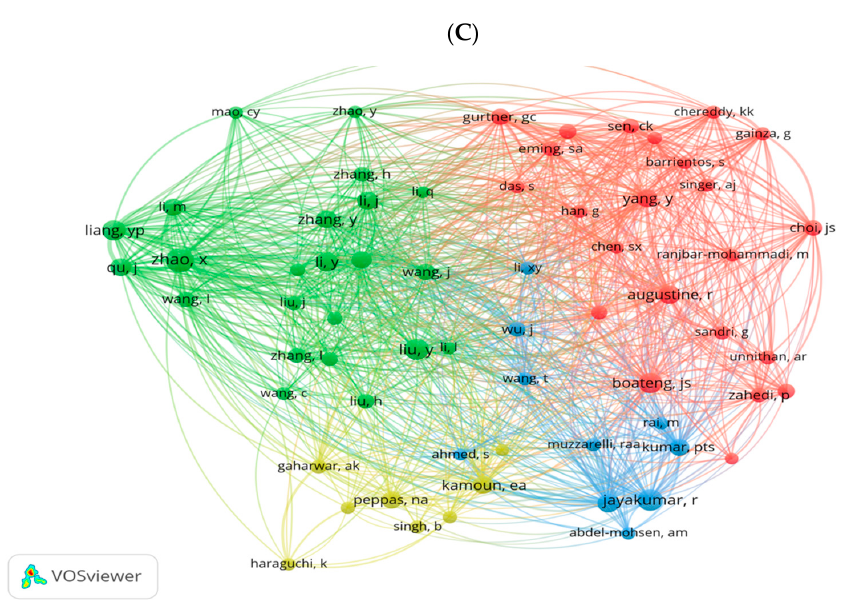
Figure 7. ( A ) The total citations (×100), average citation per paper (×10), and H-index of the top 5 most prolific authors. ( B ) The network map of authors for NDSRSs in the wound healing field. ( C ) Author co-citation analysis by VOSviewer.